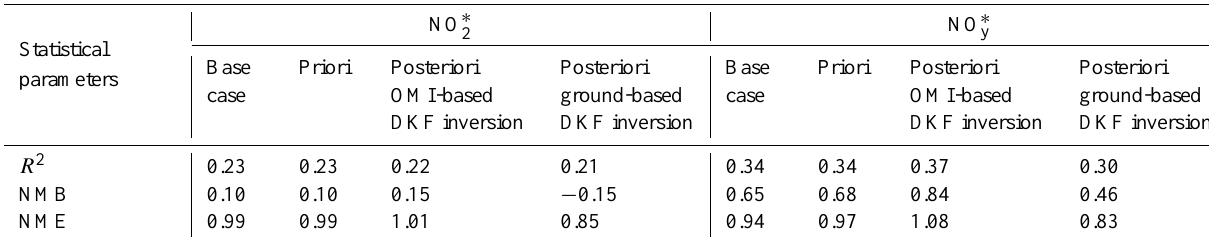
Table 5. Performance of CAMx in simulating P-3 aircraft-observed NO 2 and NO y .